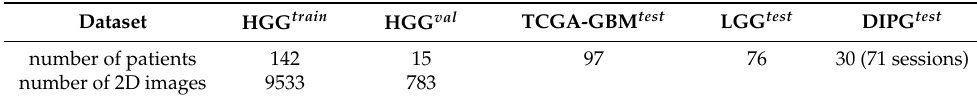
Table 1. Dataset sizes of the different training and testing sets.